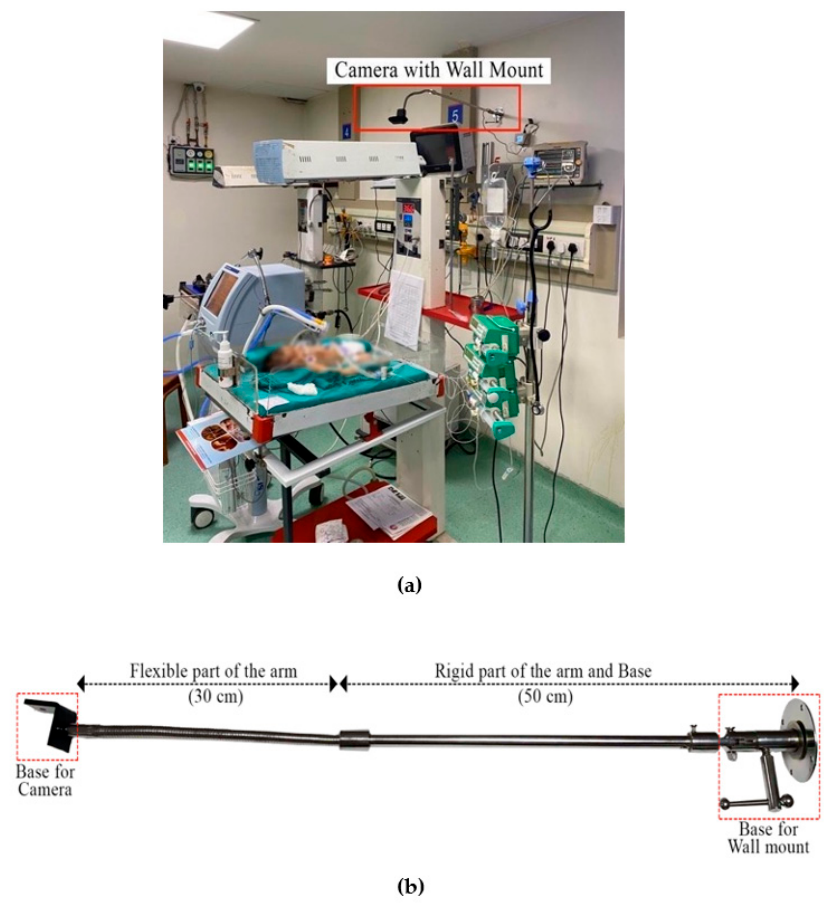
Figure A1. ( a ) Camera installed on custom-made wall mount to monitor the neonate in a Neonatal Intensive Care Unit (NICU). ( b ) Wall mount for the camera showing different sections. The wall mount weighs 1